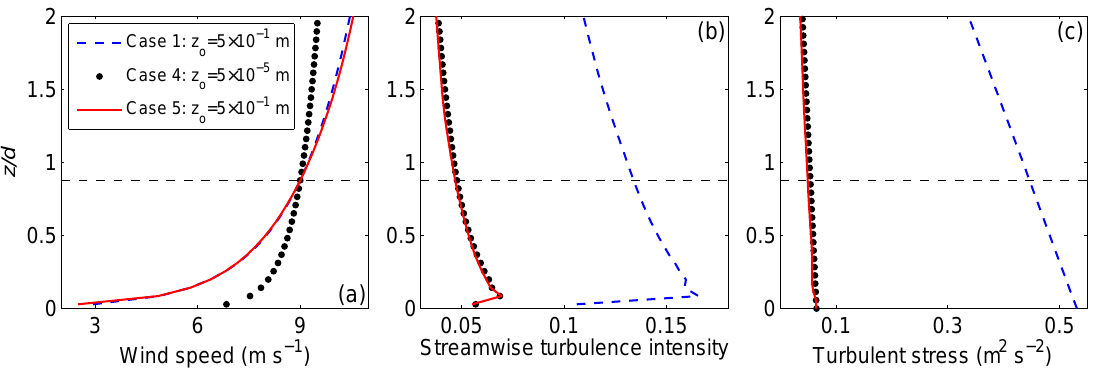
Figure 11. Vertical profiles of ( a ) the time-averaged streamwise velocity u (m s − 1 ); ( b ) the streamwise turbulence intensity I ; and ( c ) the kinematic shear stress − u (cid:48) w (cid:48) (m 2 s − 2 ) of the u incoming turbulent boundary layer